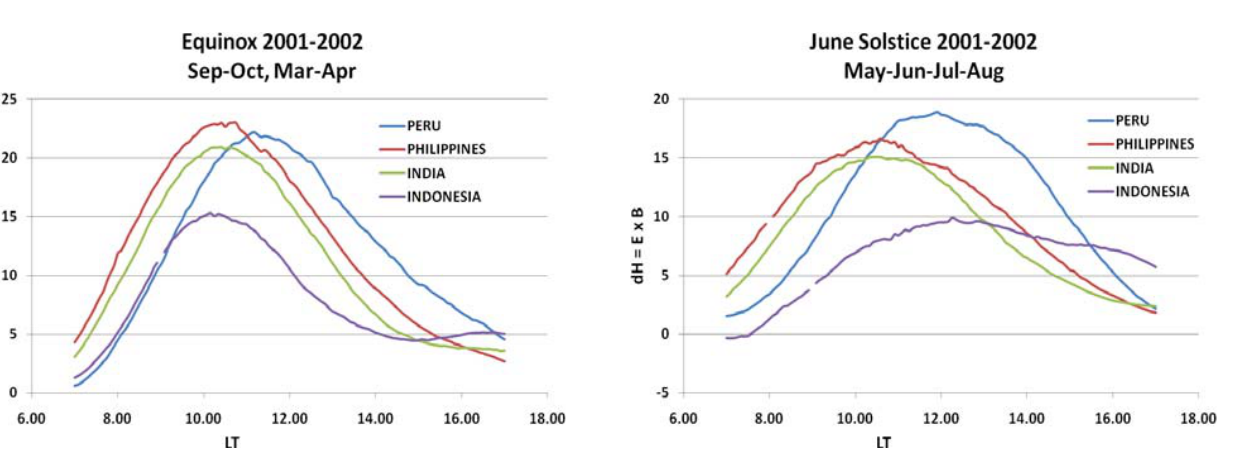
Fig. 4a. Same as Fig. 3a for June solstice. Fig. 3a. Average E × B drifts for Equinox 2001–2002 in the Peru- Figure 3a. Average ExB drifts for Equinox Figure 3b. TOPEX relative TEC as a Figure 4a. Same as Figure 3a for June solstice Figure 4b. Same as Figure 3b for June vian, Philippine, Indonesian and Indian sectors (see text for details). 2001-2002 in the Peruvian, Philippine, function of geographic longitude Solstice. Indonesian and Indian sectors (see text for and magnetic latitude for Equinox details). 2001-2002 and 12-16 LT (see text for details).